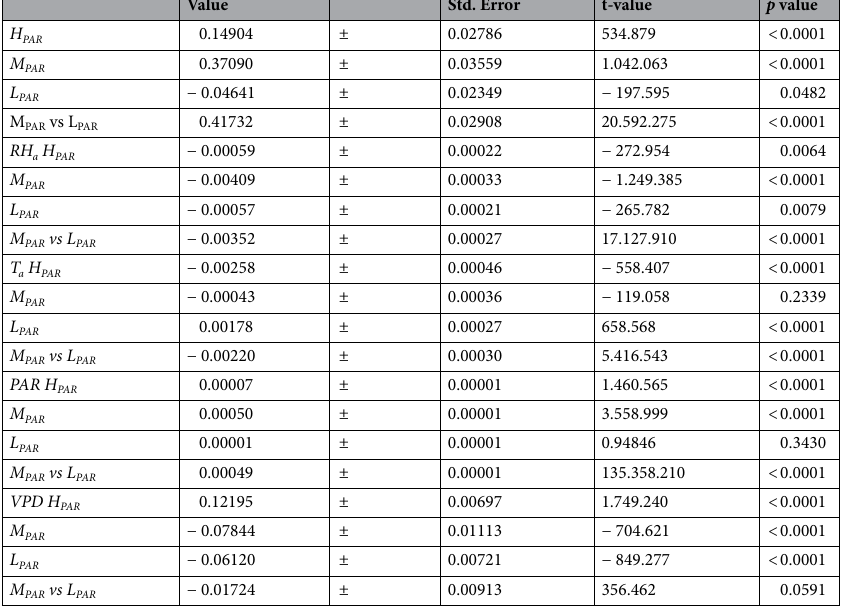
Table 4. Coefficients of the best model (according with AIC and BIC criterion) predicting sap flow ( V s ) as a function of a set of microclimatic variables across the different radiation intensities for cacao plantations in the Colombian Amazon. The types of AFs and legend are described in the methods section and Fig. 2 . The microclimatic variables are: air relative humidity ( RH a , %); air temperature ( T a , °C); photosynthetically active radiation ( PAR , µmol m −2 s −1 ); and vapor pressure deficit ( VPD , kPa). The types of AF were included as dummy variables in the regression model to control for potentially effects of different agroforestry arrangements and incident radiation intensities on microclimatic variables and sap flow across AFs. The first three coefficients (Value) shown in the table are: the value for H PAR corresponds to β 0 (see Eq. 3) in H PAR , the value for M PAR corresponds to the difference between H PAR -β 0 and M PAR -β 0 , the value for L PAR corresponds to the difference between H PAR -β 0 and L PAR -β 0 . The following groups of coefficients (row blocks separated by a line) correspond to the coefficients for each microclimatic variable and is interpreted in the same way as described above but applied to the partial slope for each microclimatic variable. In all cases, the M PAR vs L PAR rows show the difference between their estimated coefficients.